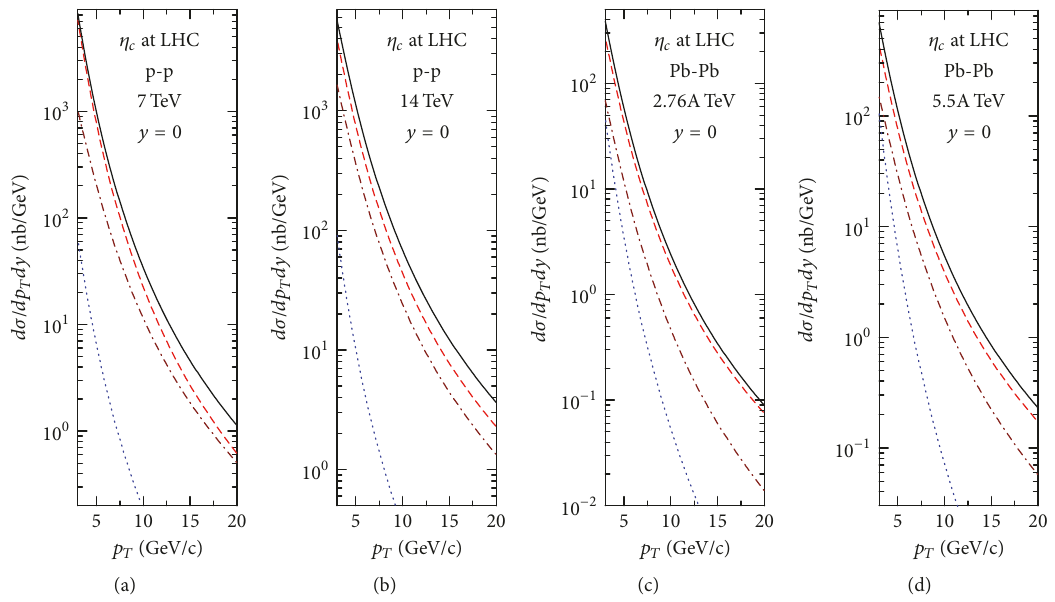
Figure 1: The invariant cross section of large- 𝑝 𝑇 𝜂 𝑐 meson production from gluon-gluon interaction at midrapidity in p-p collisions ( √𝑠 = 7.0 TeV and √𝑠 = 14.0 TeV) and Pb-Pb collisions ( √𝑠 = 2.76 TeV and √𝑠 = 5.5 TeV) at the LHC. The dashed line (red line) is for the initial gluon-gluon interaction (LO), the dotted line (blue line) for the semielastic hard photoproduction g-g processes (semi.), the dashed-dotted line (wine line) for the inelastic hard photoproduction g-g processes (inel.), and the solid line (black line) for the sum of the above processes.